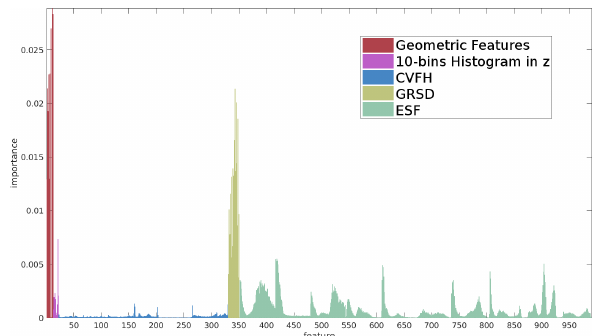
Figure 6: Features Importance